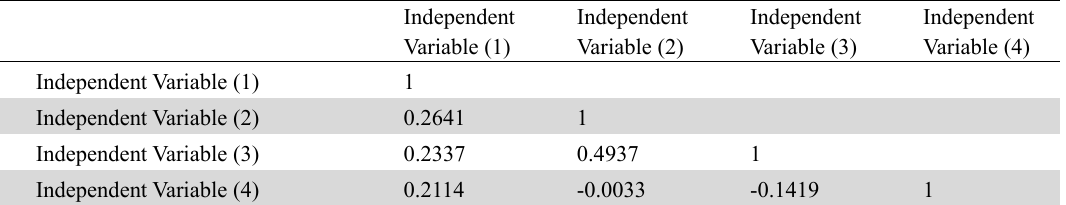
Table 1. Correlation between independent